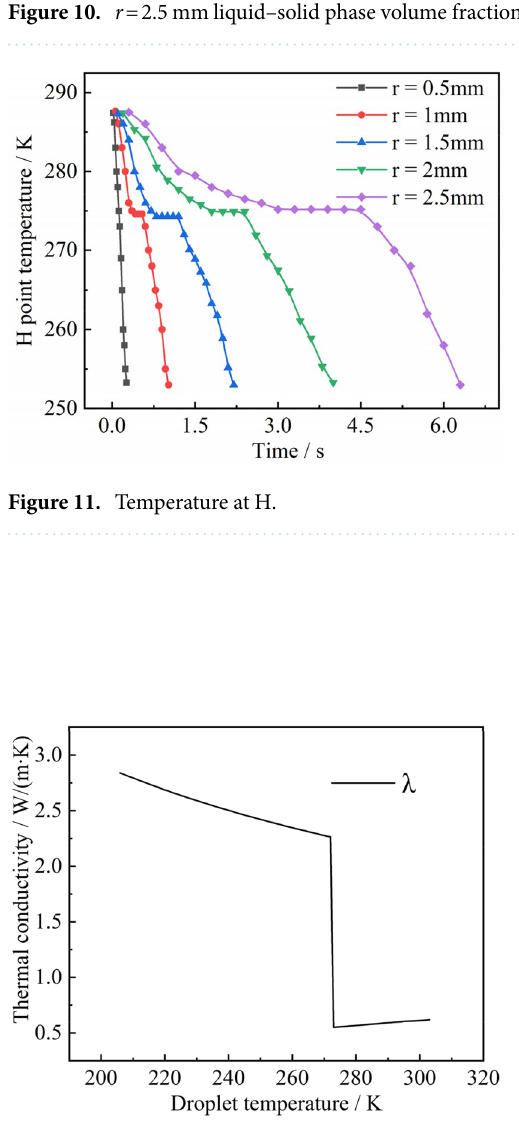
Figure 12. Thermal conductivity of liquid